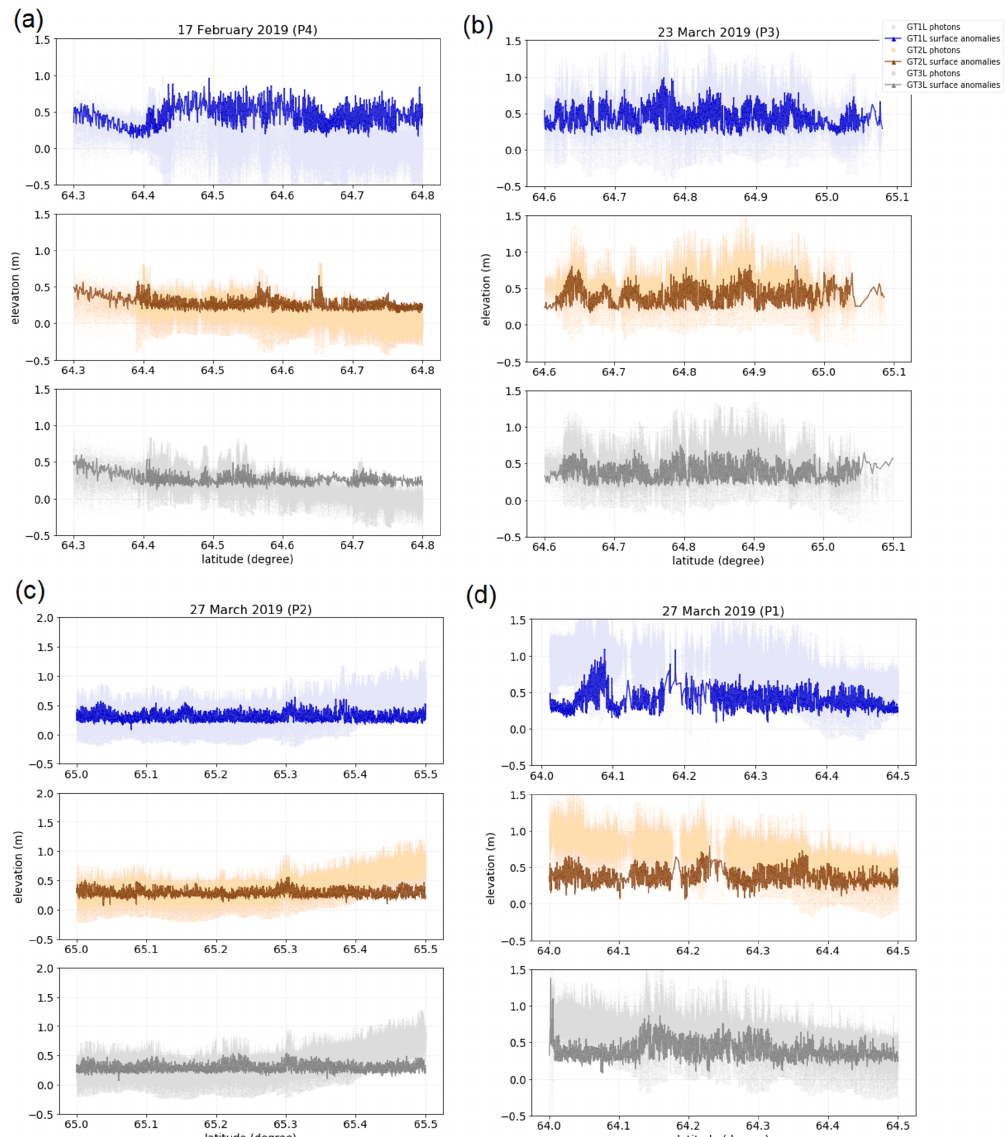
Figure 7. Photon profiles (P1–P4) of strong beams ATL03 photons (separated into each strong beam; GT1L, GT2L, GT3L) with elevation anomalies overlaid for four cases (see Tables 1 and 3 for specifications; the figures are representing (a) case for Region E on 17 February 2019, (b) case for Region J on 23 March 2019, (c) case for Region L on 27 March 2019 and (d) case for Region B on 27 March